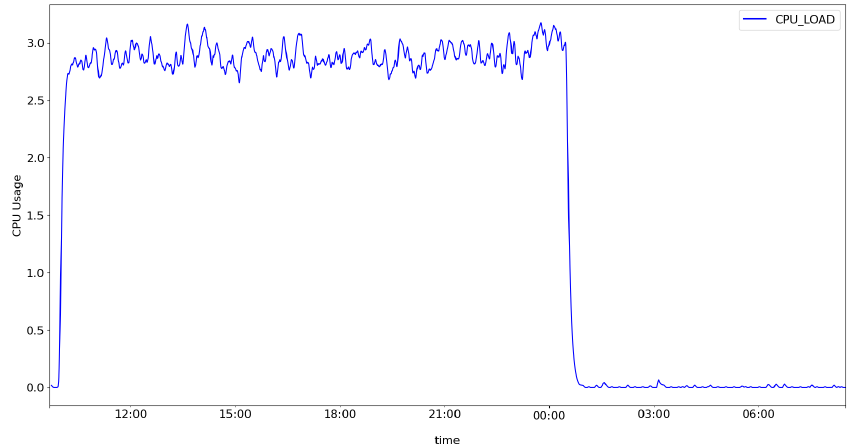
Figure 8. CPU performance during analysis of network flows.